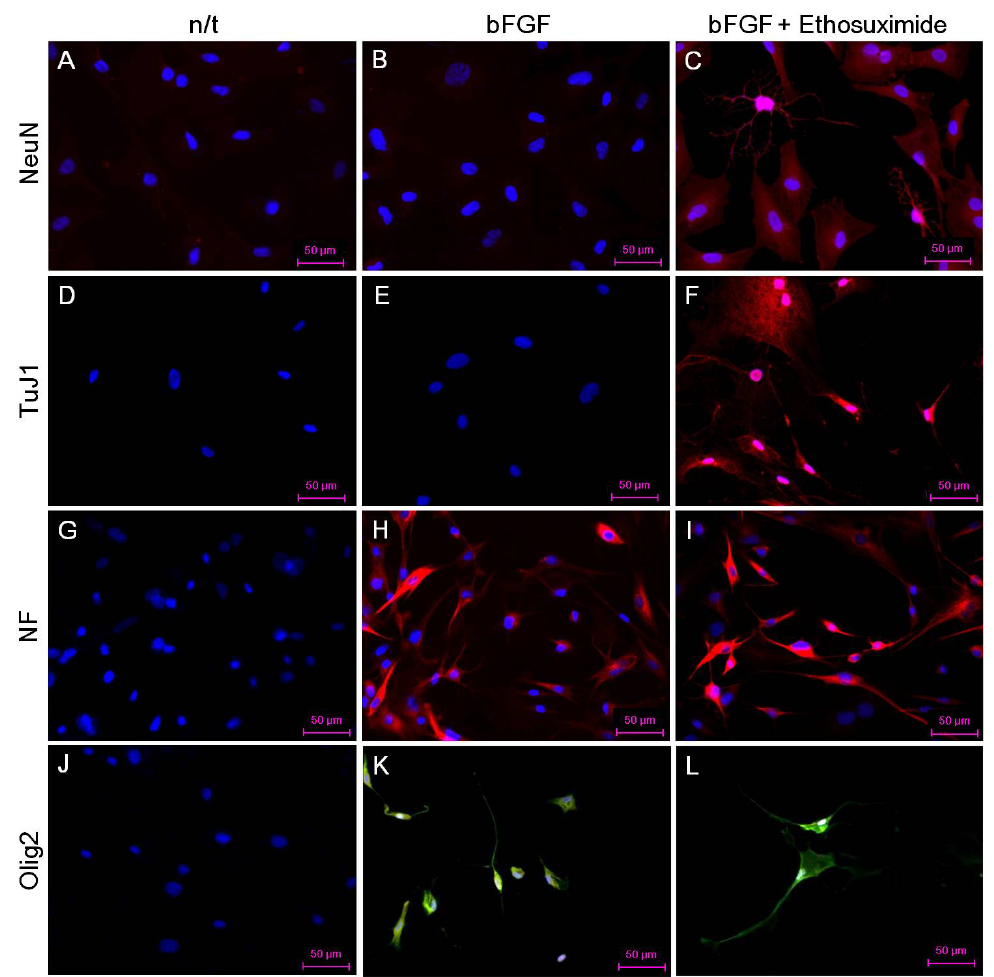
Figure 3. Fluorescence immunostaining of rMDSCs. First column, rMDSCs without any stimulant; second column, rMDSCs differentiated with bFGF; third column, rMDSCs differentiated with bFGF and ethosuximide. First line, NeuN fluorescence immunostaining; second line, TuJ1 fluorescence immunostaining; third line, NF fluorescence immunostaining; fourth line, Olig2 fluorescence immunostaining. Each immunostaining performed with rMDSCs at 5 days after pre-induction of neurogenesis. Magnification is ×400 and scale bar represents 50 μ